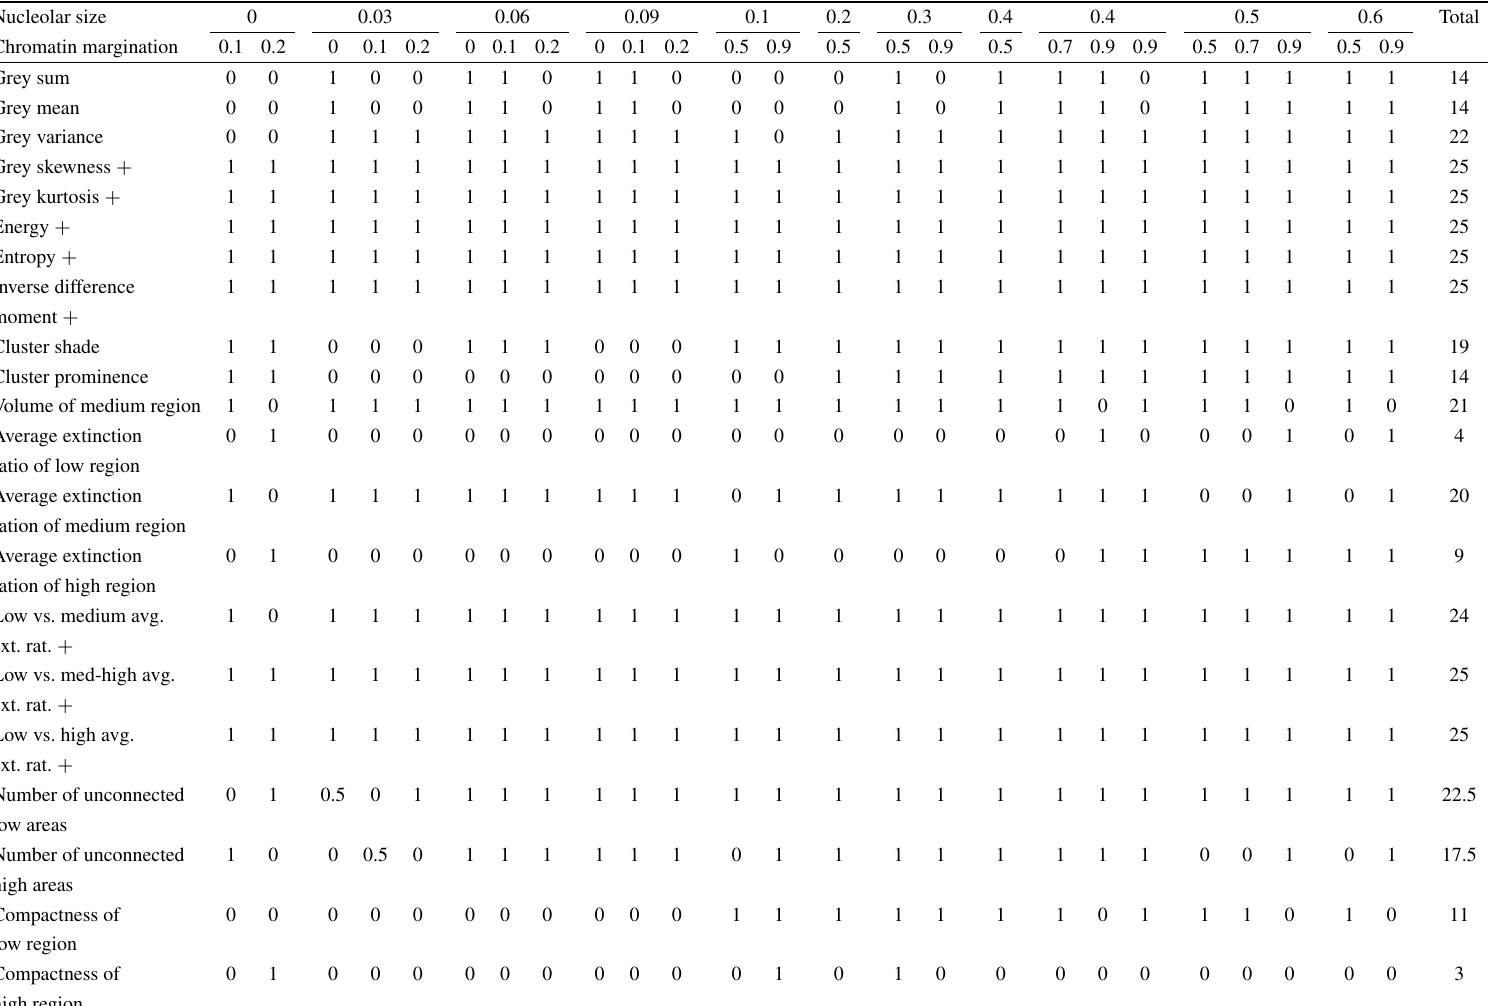
Discriminative power for artificial 3-D nuclei with varying nucleolar size and degree of chromatin margination of 3D nuclear texture features yielding an area under the curve in ROC analysis of 0.5 and higher. Texture features marked with a plus sign indicate a low sensitivity to the effects of these